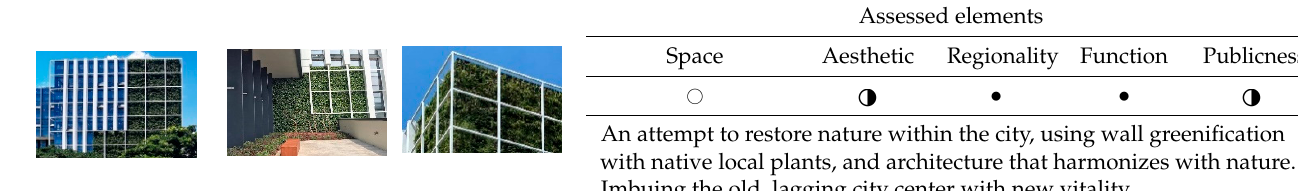
Table 9. Adaptive facades: Seogwipo City Hall (Sun Architects 2016).